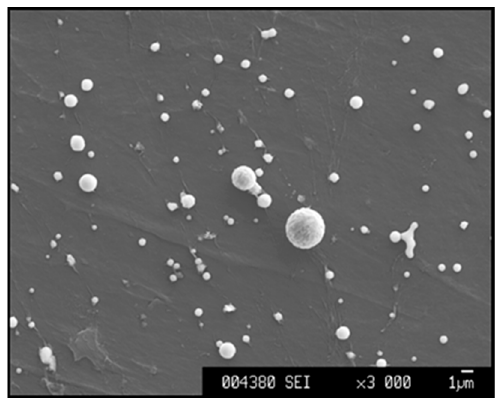
Figure 2. SEM images of inclusions and clusters observed on film filter after electrolytic extraction. The diameter of spherical inclusions as well as the maximum length ( l ) and width ( w ) of non-spherical inclusions and clusters were measured on SEM images. The aspect ratio ( AR ) of inclusions and clusters was calculated as a ratio between their length